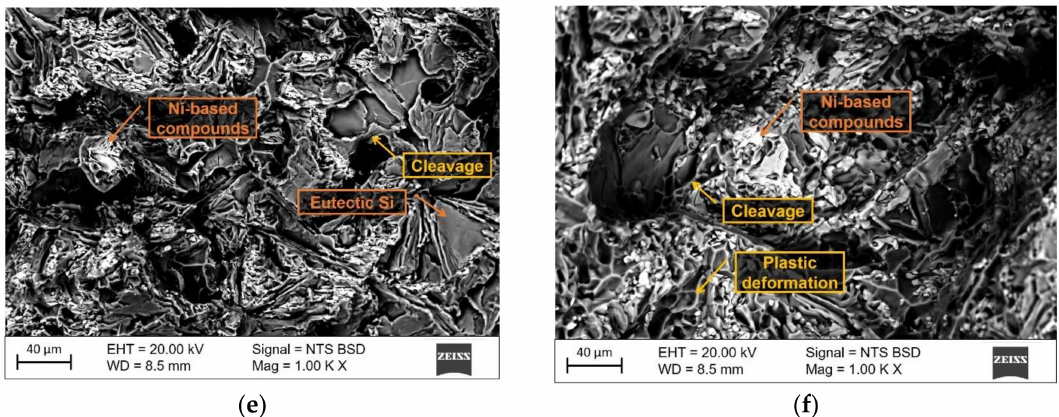
Figure 5. Fracture surfaces (backscattered electron images) of the alloys containing 0.5 ( a , b ); 1 ( c , d ) and 2 ( e , f ) wt % Ni: ( a , c , e ) as-cast condition; and ( b , d , f ) T6 condition.